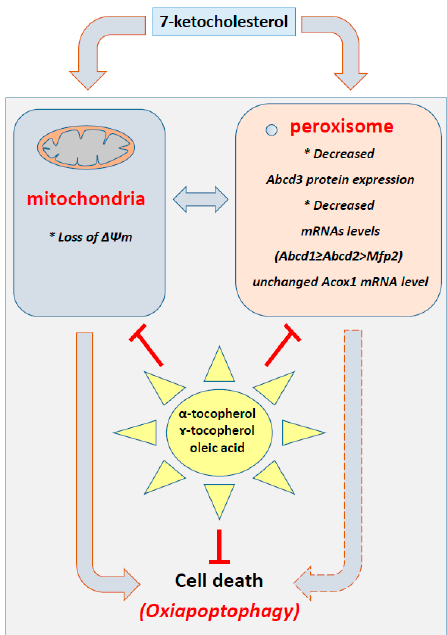
Figure 6. Impairment of 7-ketocholesterol-induced mitochondrial and peroxisomal dysfunction with α -tocopherol, and γ -tocopherol, and oleic acid, major compounds of the Mediterranean diet, in murine microglial BV-2 cells. Under treatment with 7-ketocholesterol, which is found at increased levels in the plasma and cerebrospinal fluid of patients with demyelinating diseases, such